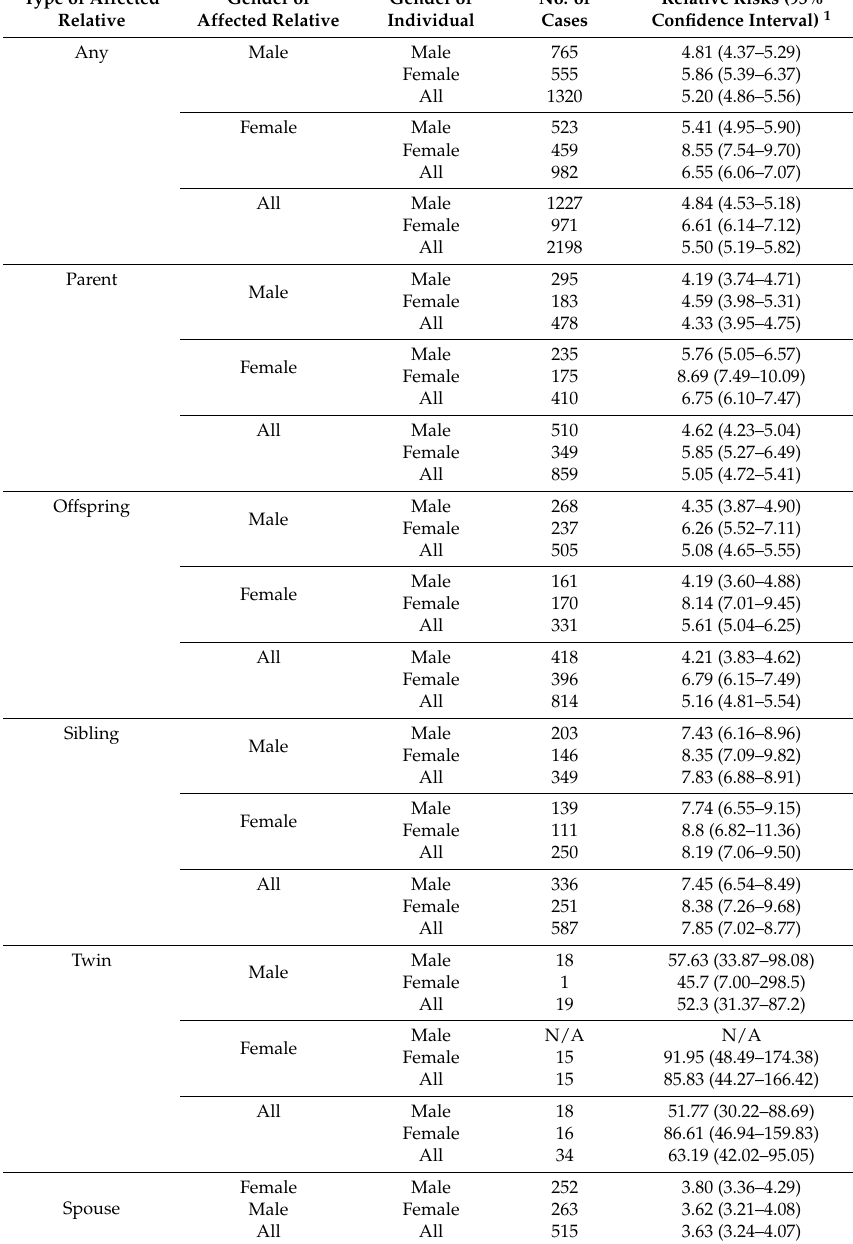
Table 2. Relative risks of psoriasis in individuals with first-degree relatives diagnosed with psoriasis. Type of Affected